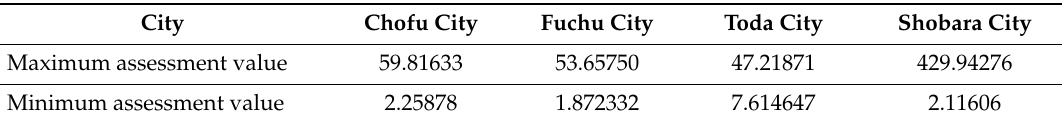
Table 4. Results without a weighted coe ffi cient.